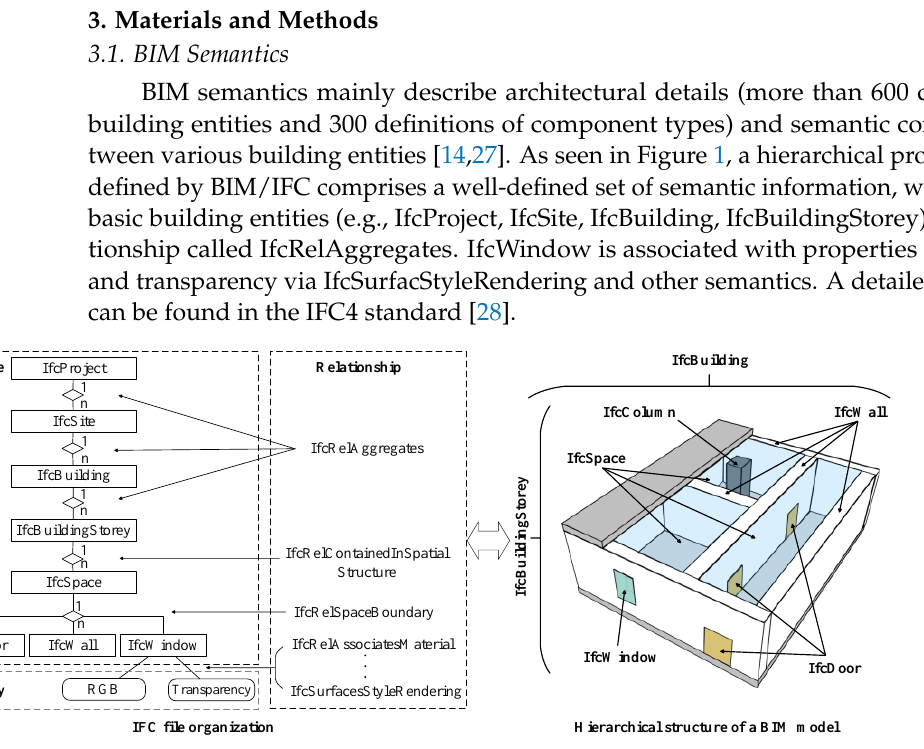
Table 1. Definition of “visibility”.